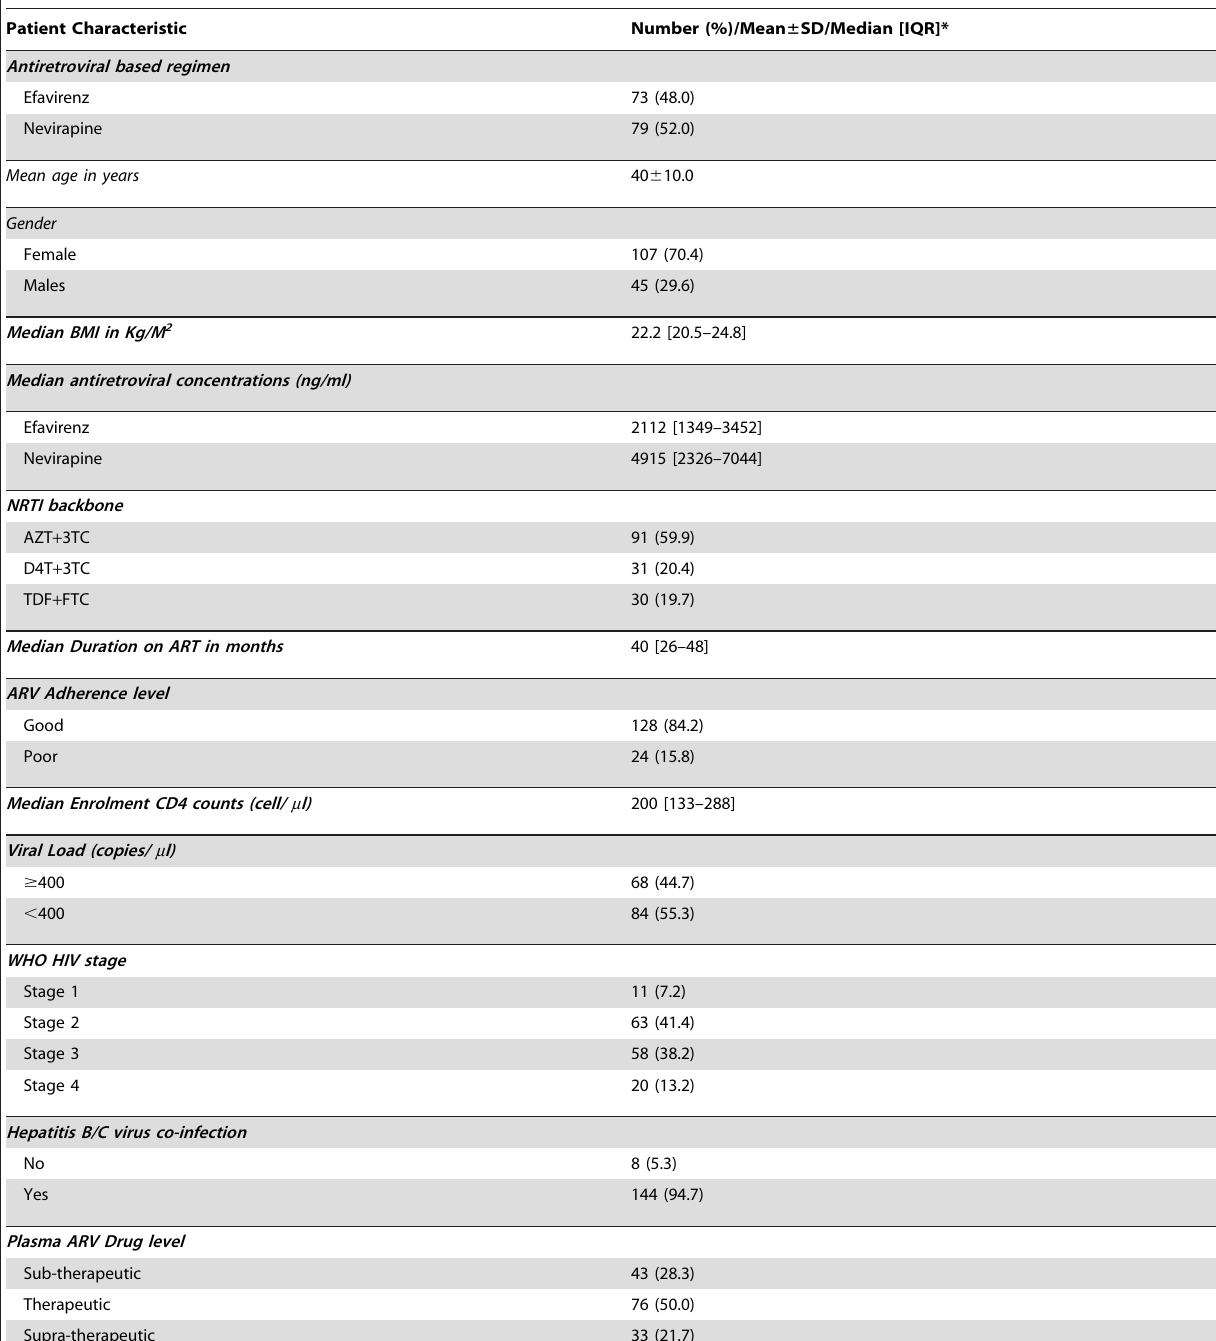
Table 1. Distribution of patients’ characteristics among 152 participants.